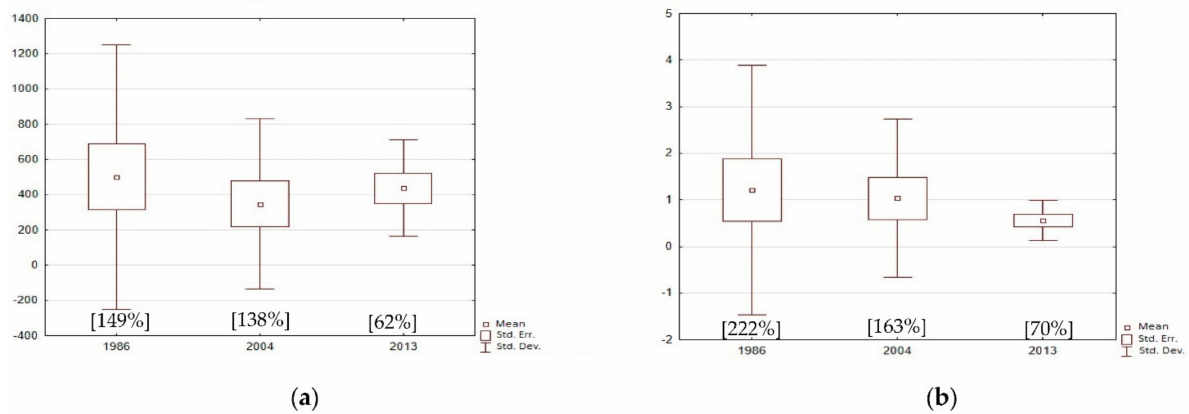
Figure 4. Variability (mean values, standard error, standard deviation) of the abundance [indiv. L − 1 ] ( a ) and biomass [mg l − 1 ] ( b ) of rotifers in Lake Kortowskie; all differences were insignificant ( p > 0.05); [variability indices in parentheses].